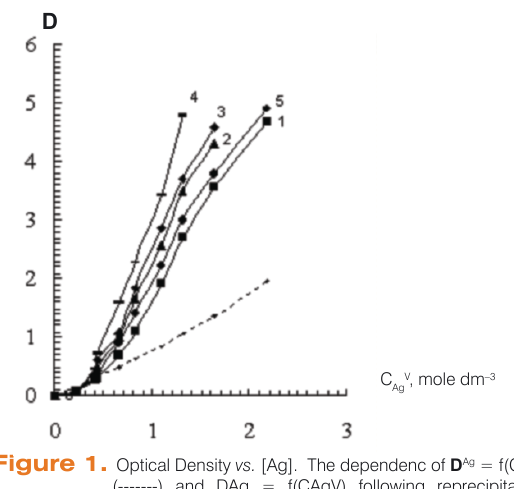
Figure 1. Optical Density vs. [Ag]. The dependenc of D Ag = f(C (-------) and DAg = f(CAgV) following reprecipitation by thereduction process, Ag sodium trioxosulphidosulphate(VI) as CR at varying concentrations: 2.0 g L –1 (curve 1), 4,0 g L –1 (2), 8,0 g L –1 (3), 24.0 g L –1 (4) and 40.0 g L –1 (5). The optical densities were measured with a blue light-filter with a transmission maximum at 450 nm.